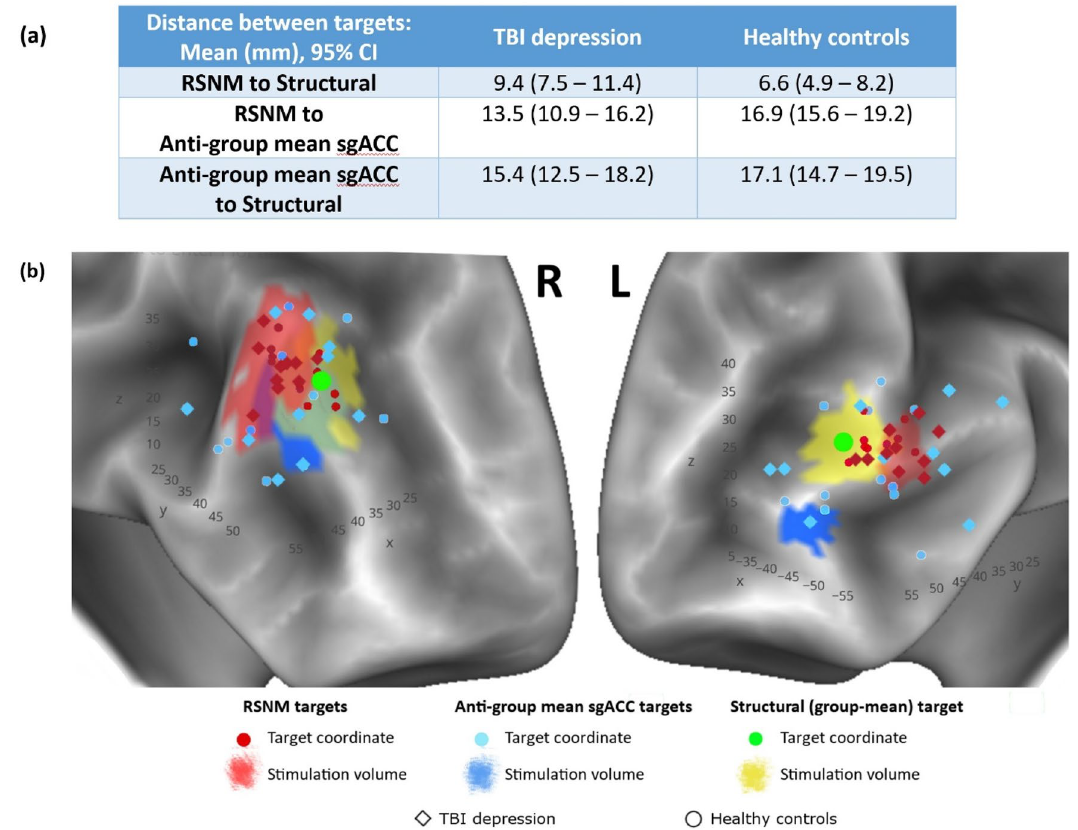
Figure 4. Anatomical distributions of targets yielded by the three approaches. Targets are displayed on a 3D surface rendering to facilitate visual comparison; the analyses were conducted in volume space. ( a ) Mean and 95% confidence interval for the Euclidean distance between target coordinates generated by the different methods. ( b ) 3D scatter plot of the target sites generated by the different methods to illustrate approximate spatial distribution of targets. Background is a representative example of a single-subject surface reconstruction with approximate predicted stimulation volumes in that subject (in the TBI depression group). These approximate stimulation volumes are cortical surface projections of the estimated 15-mm sphere centered at the stimulation site for that subject; shapes are asymmetric and irregular due to normal variation in cortical surface anatomy. Across all subjects and in this representative example, RSNM-based actual stimulation sites were different from the structural group-mean site (green